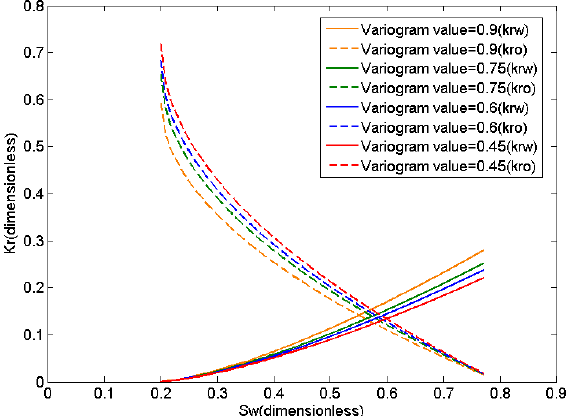
Figure 7. Relative permeability with different variogram values.